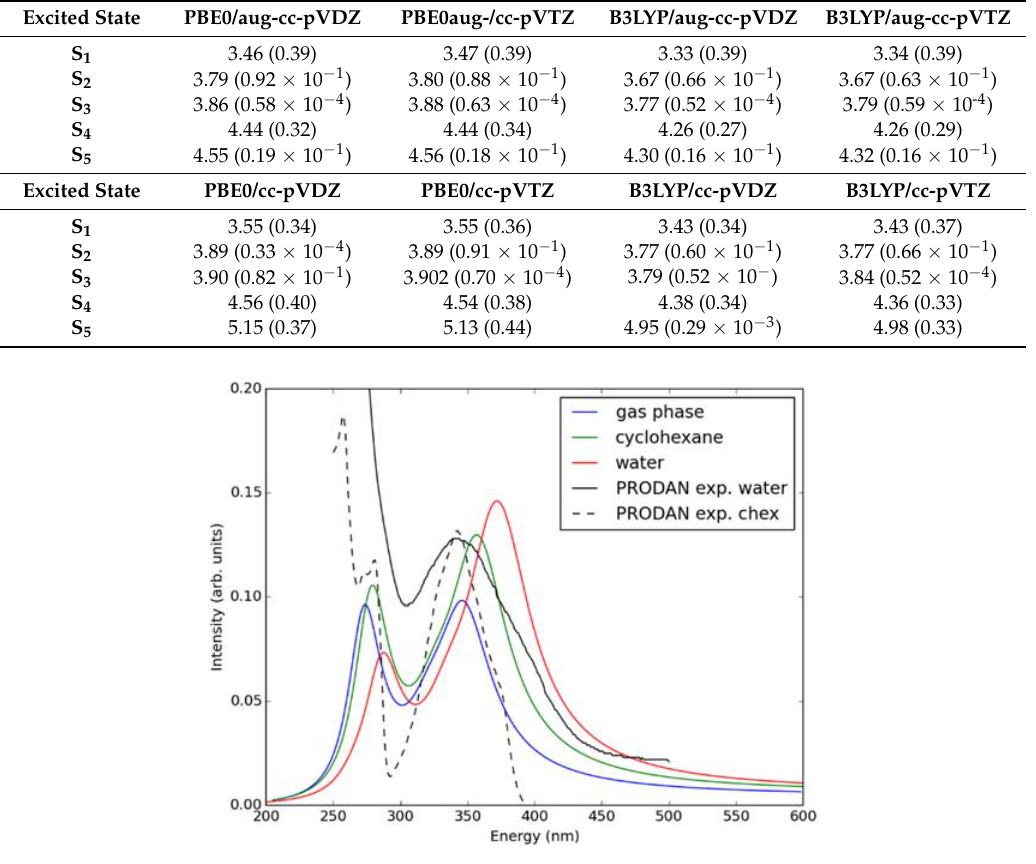
Figure 2. Simulated absorption spectra of LAURDAN in the gas phase, water, and cyclohexane using the TD-DFT/PBE0/cc-pVDZ method. Experimental spectra (taken from Ref. [7]) measured for PRODAN in water and experiment are shown for comparison.